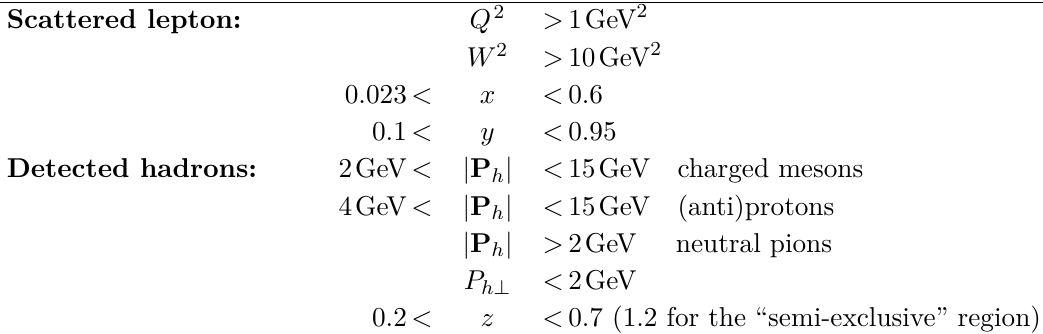
Table 3 . Restrictions on selected kinematics variables. The upper limit on z of 1.2 applies only to the analysis of the z dependence.